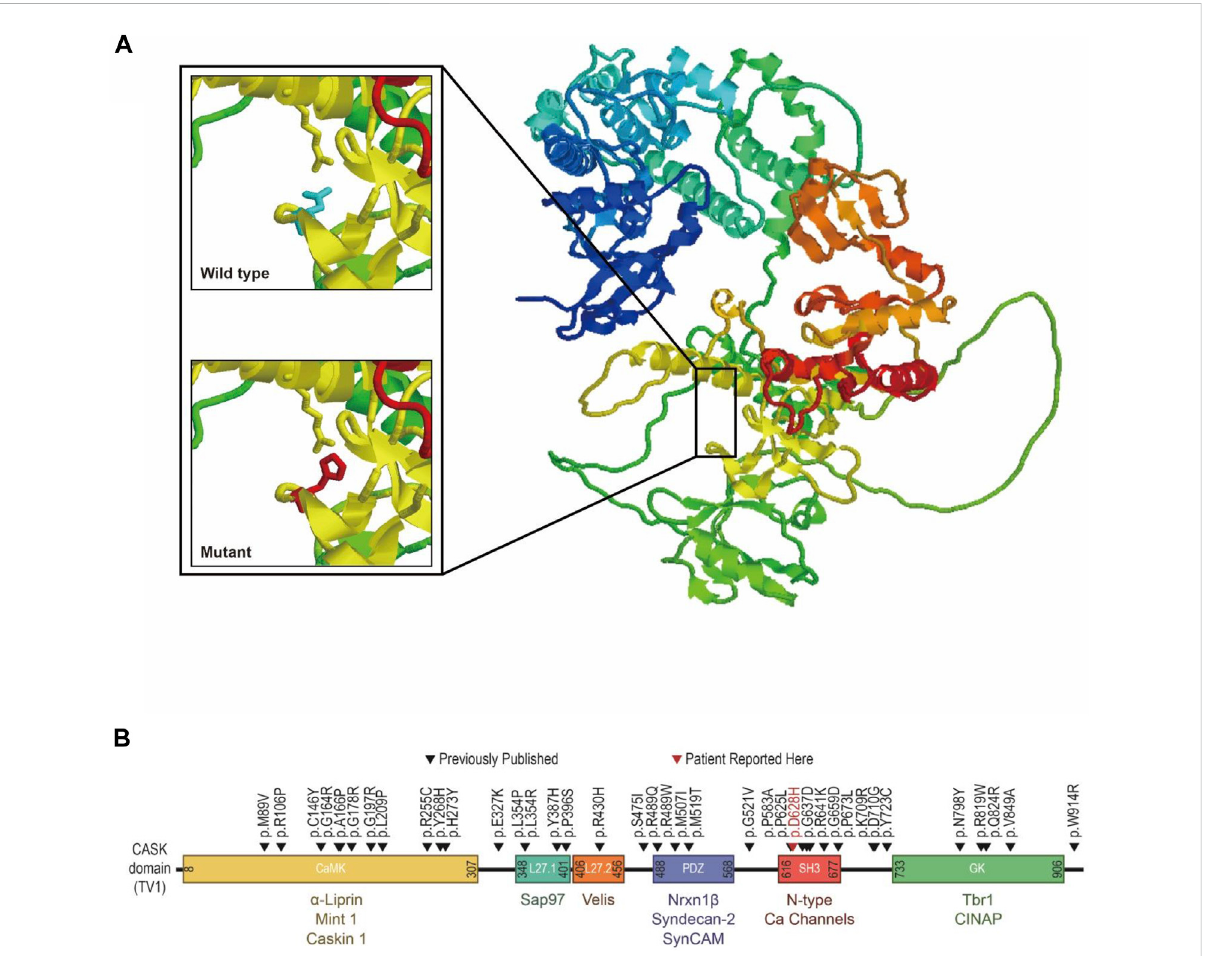
FIGURE 4 Structural prediction and positionmappingof D628H ofCASK protein. (A) Structural prediction ofwild-type Dand themutantH residues atthe 628 ° position. Bold, the wild-type and mutant side chain are shown in blue and red, respectively. (B) Position mapping of previously reported missense mutations p.D628Hin this study, CASK